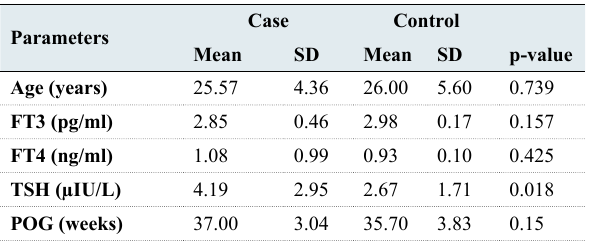
Table 1: Mean and standard deviation of Age, FT3, FT4, TSH,